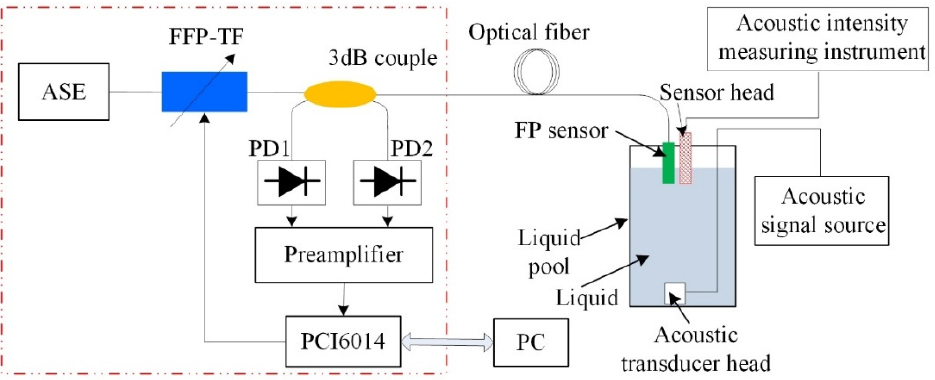
Figure 8. Schematic of the ultrasonic signal testing system.